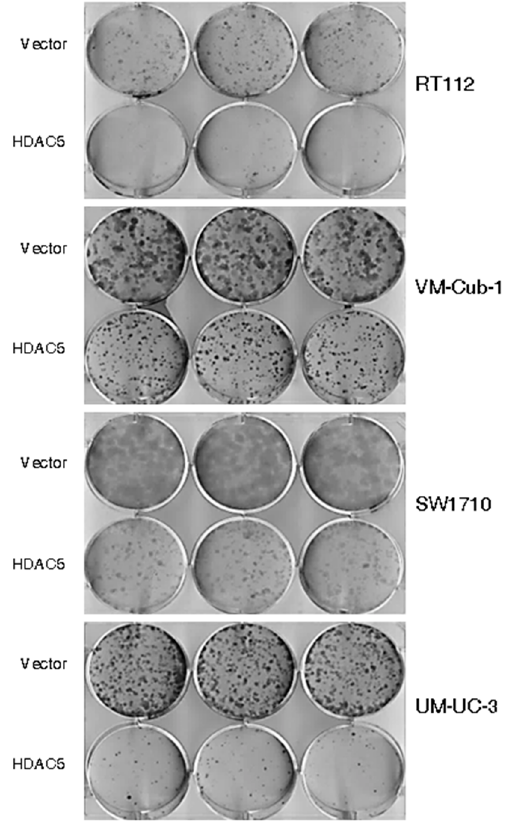
Figure 3. Effect of HDAC5 on clone formation. Representative pictures of clone formation assays after seeding of equal numbers of cells from the indicated vector-only or HDAC5-transduced UCCs.